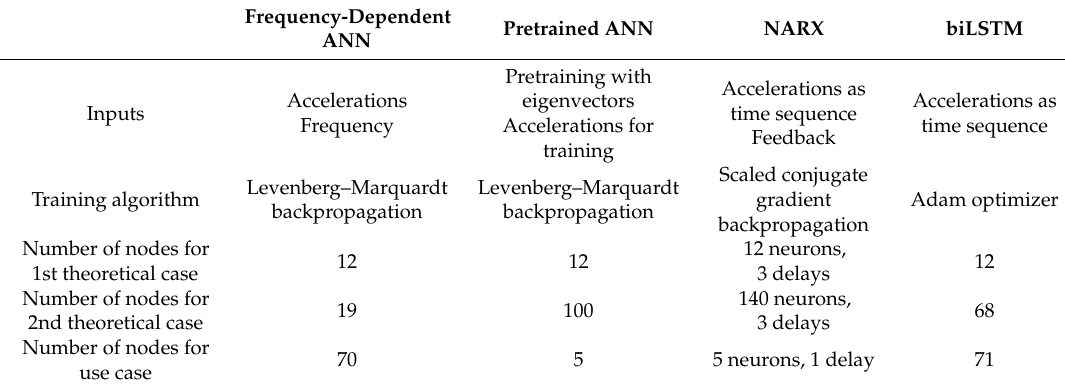
Table 1. Architecture of the different ANNs.